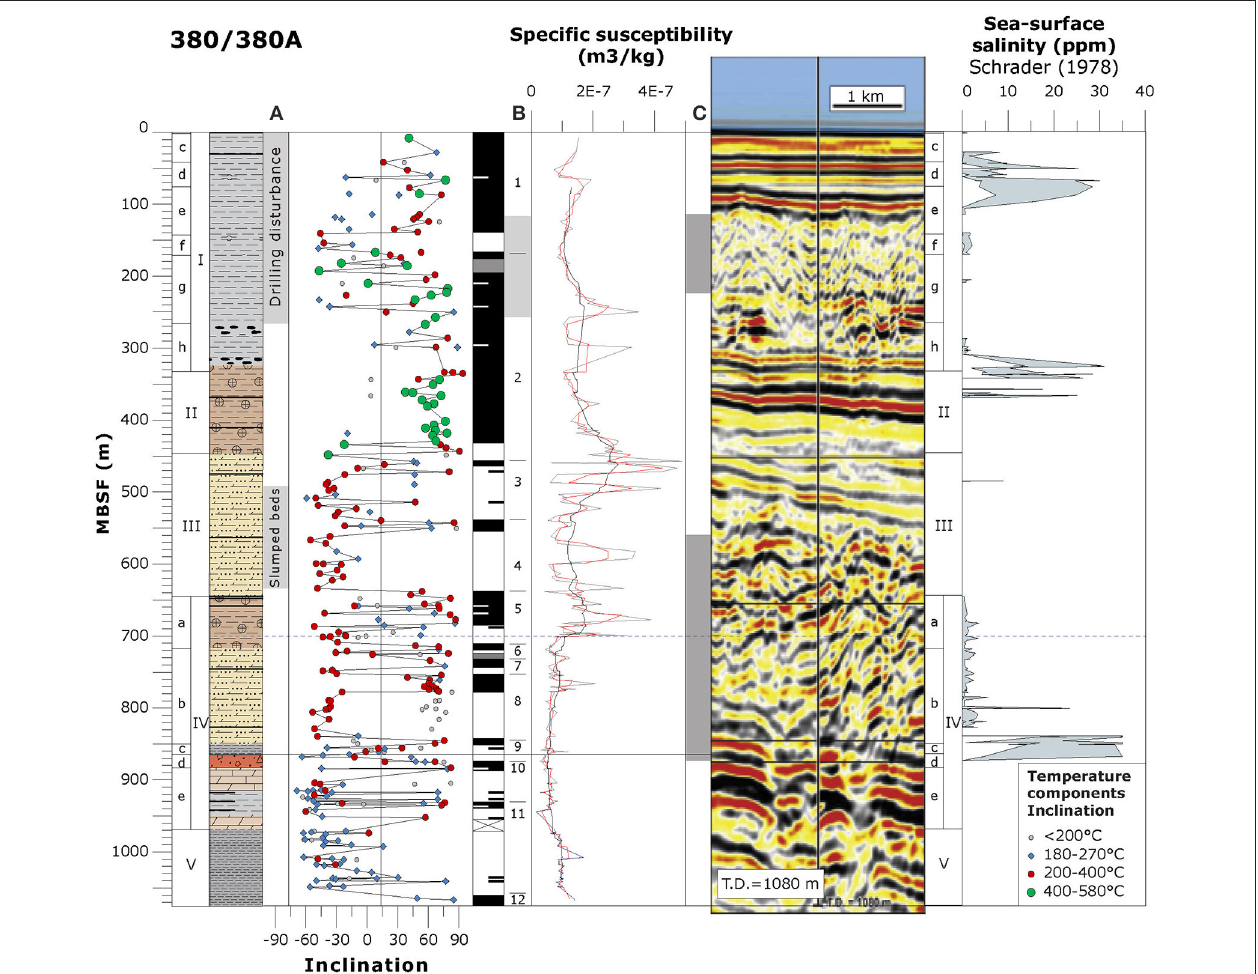
FIGURE 6 | Magnetostratigraphic results for Hole 380/380A compared to previously published datasets. From left to right: Depth-scale; lithological units, unit I is divided in eight subunits (a–h) , consisting of (a) nannofossil ooze, (b) sapropel, (c) muds and sandy silts, (d, f) diatomaceous mud, (e, g) muds, and (h) muds and turbidites; lithology (similar to Figure 1 ); column (A) , Interpretation of deformation structures in the core ( Shipboard Scientific Staff, 1978b); Measured inclination; Polarity interpretation, in gray column (B) , potential disturbance; Polarity zone label; Specific magnetic susceptibility (gray: measured data, red: three point moving average; black: 25 point moving average); column (C) interpretation of mass transport units by Tari et al. (2015); Depth converted seismic transect across the drilling location of Hole 380/380A (Tari et al., 2015); lithological units; diatom-based sea-surface salinity (Schrader, 1978). Horizontal lines indicate the borders of intervals of similar